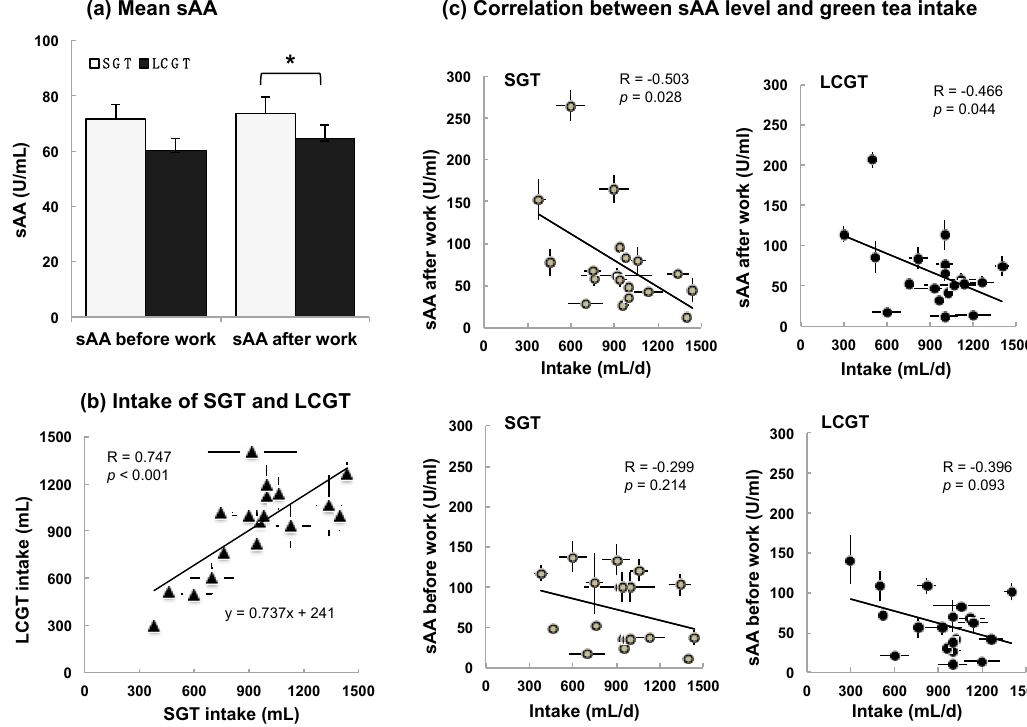
Figure 2. Anti-stress effect of LCGT. ( a ) Mean sAA level of each group. Data are expressed as mean ± SEM ( n = 19, *, p < 0.05; one-way ANOVA); ( b ) Correlation between SGT and LCGT intake; ( c ) Correlation between the level of sAA before work or after work and SGT or LCGT intake. Data of b and c are expressed as mean ± SEM ( n = 5, in each participant).